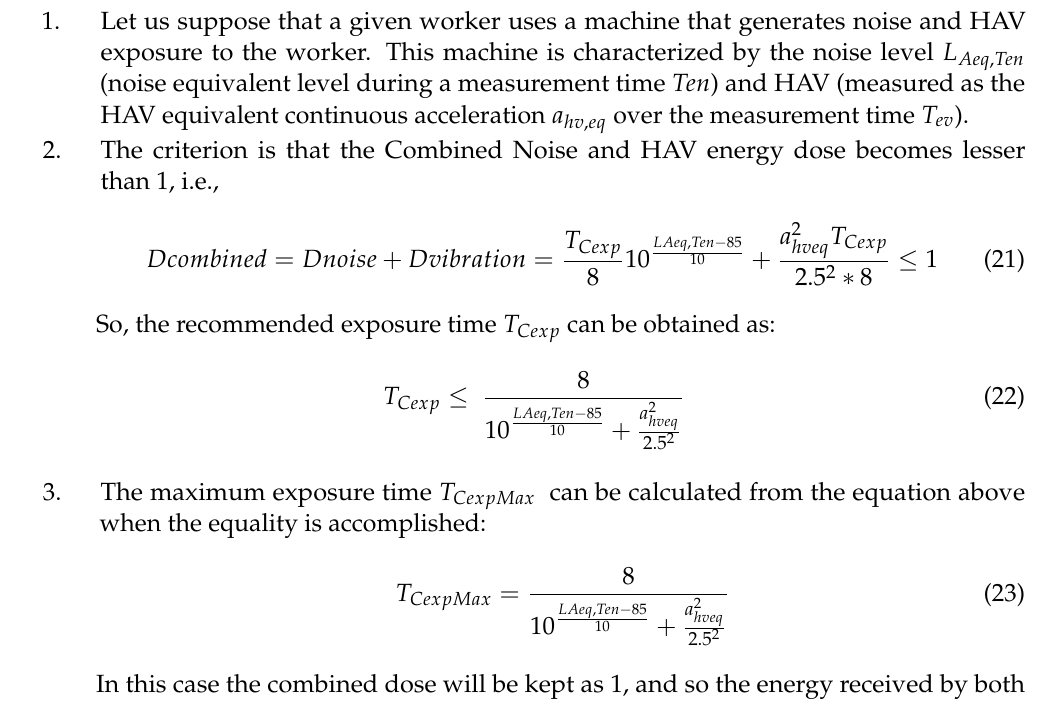
Table 2. Measured machine. Noise and vibration values declared by the manufacturer.